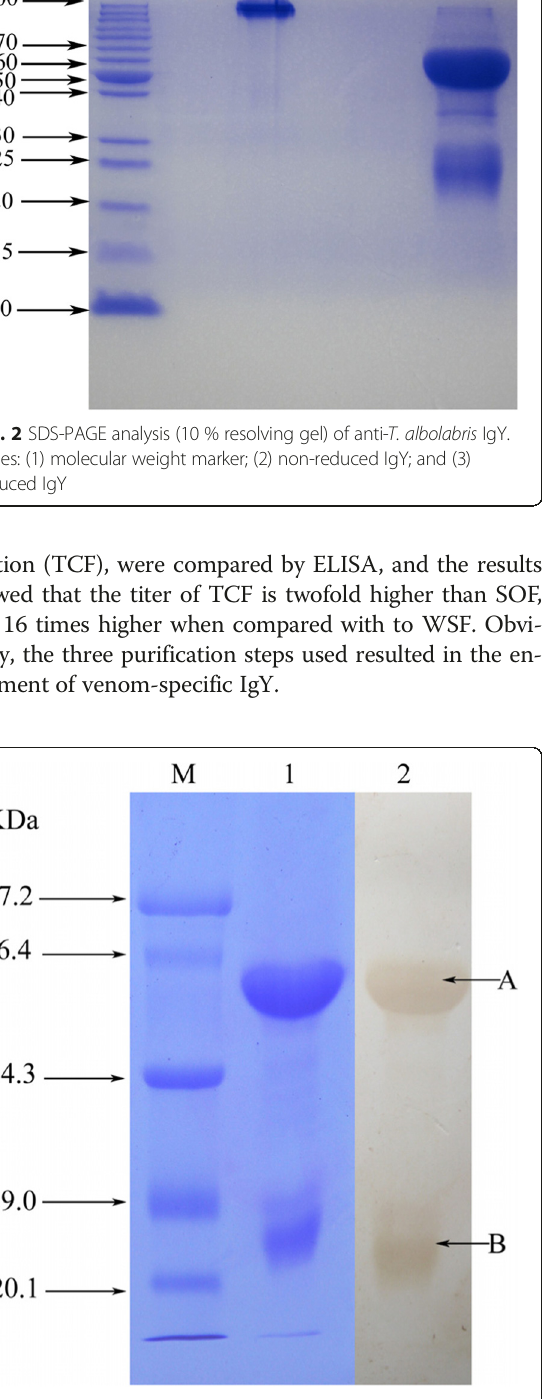
Table 1 Recovery ratio of proteins and titer of IgY fractions Fractions Titer of IgY by ELISA (×10 4 )